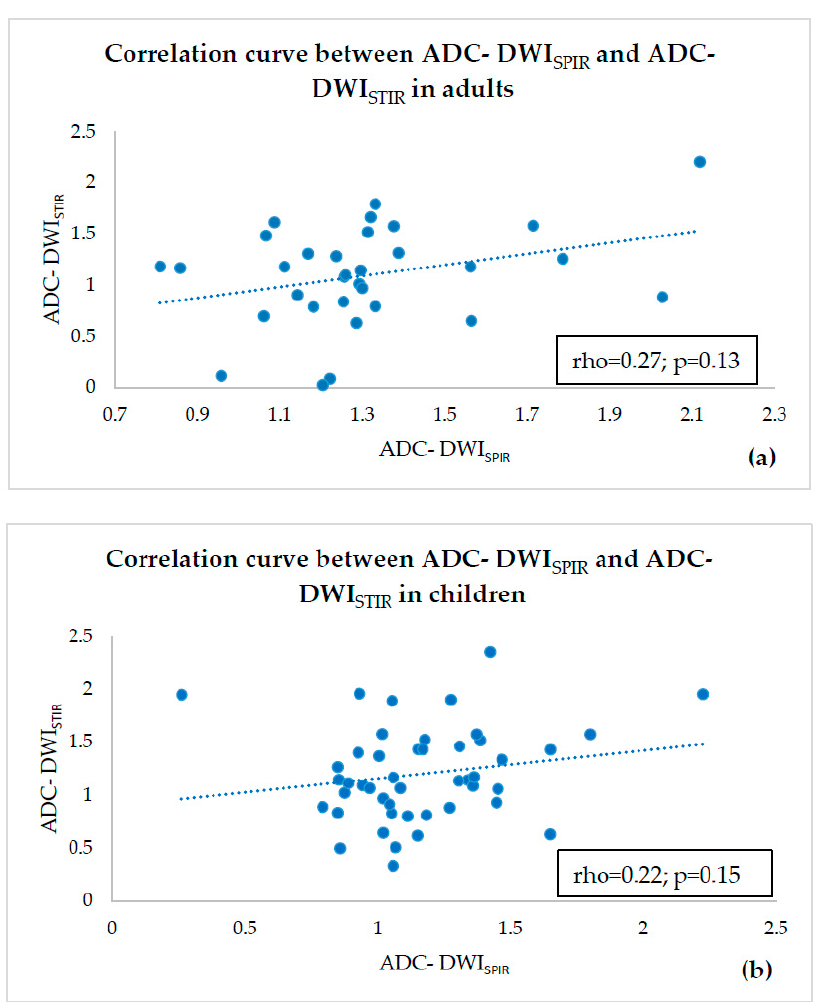
Figure 3. Correlation curve between ADC-DWI SPIR and ADC-DWI STIR in adults ( a ) and children ( b ) showing no correlation.